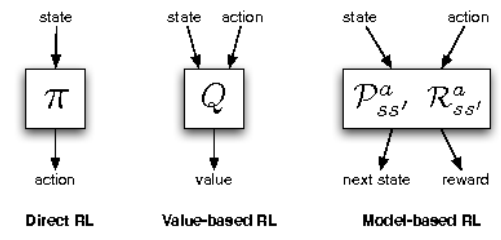
Figure 1. Different Reinforcement Learning